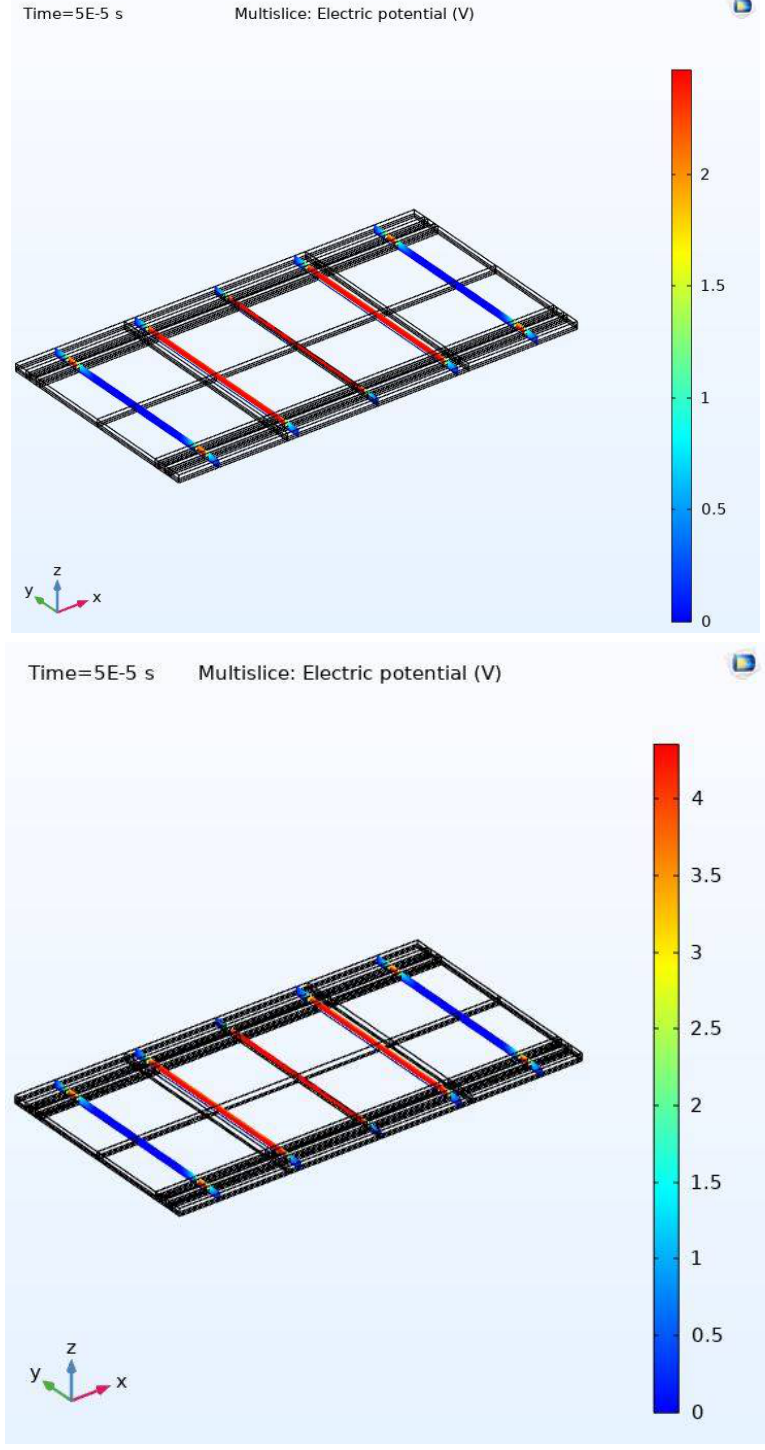
Figure 17. Control input (voltage) at two positions: top graph (0.046 μm ), bottom graph (0.9 μm ).